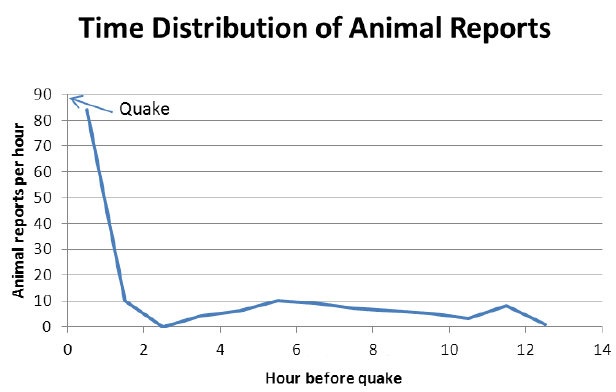
Fig. 3. Animal precursor reports each hour before the